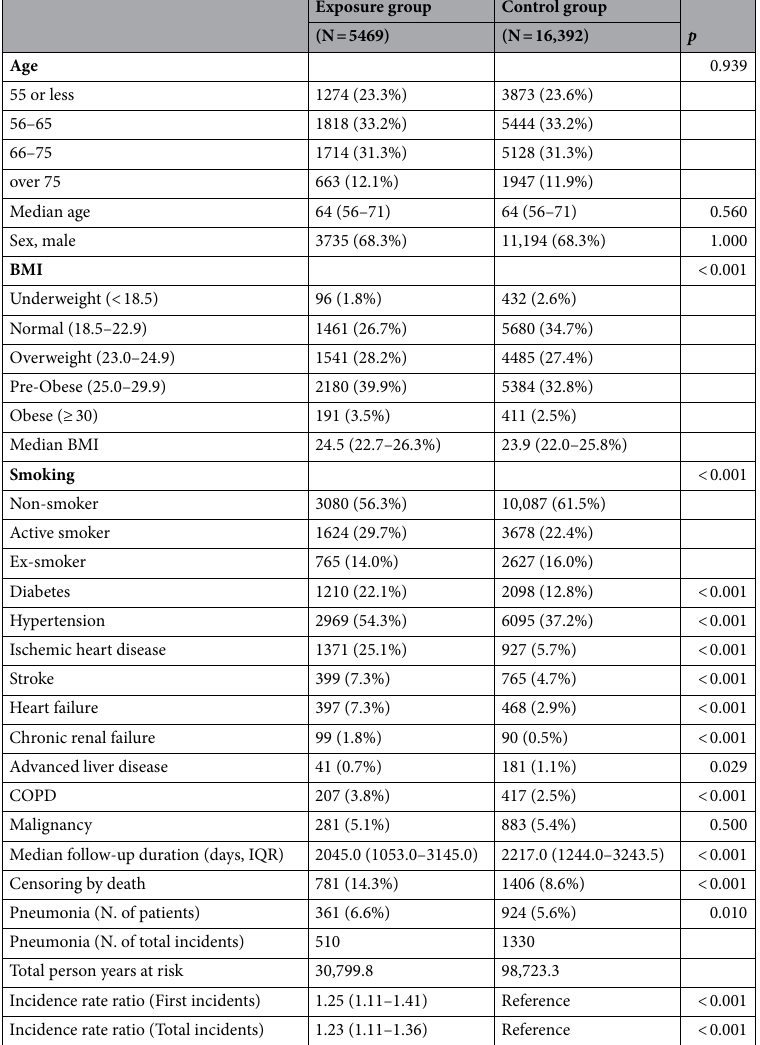
Table 1. Baseline characteristics of the study cohort. BMI: Basal mass index; COPD: Chronic obstructive pulmonary